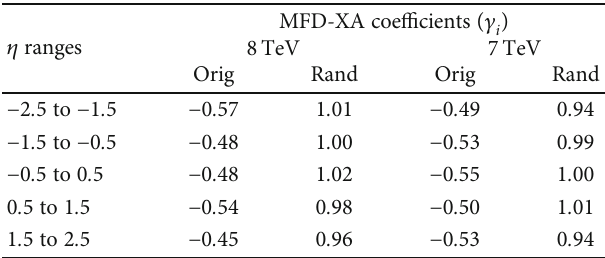
Figure 8: Comparison of multifractal cross-correlation coe ffi cient ( γ 8TeV datasets. Table 2: Comparison of the experimental values of multifractal cross-correlation coe ffi cients ( γ i ) between ϕ and η spaces for all the 5 ranges of η values for 7 and 8TeV datasets, between the original and the randomized